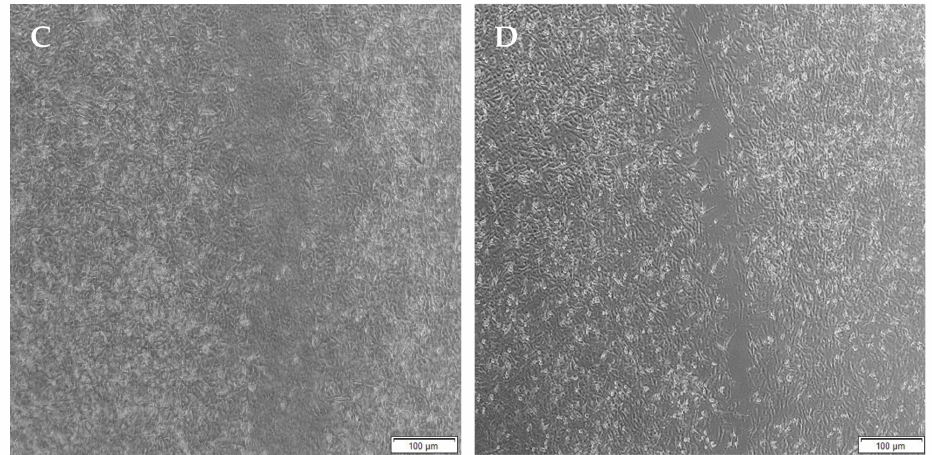
Figure 16. Micrographs of the migration of A172 cells from a wound-healing assay of the semi- IPN at ( A ) 0 h, ( B ) 8 h, ( C ) 24 h, and ( D ) 48 h. Images were captured using the 4 × objective and the phase contrast feature of an inverted light microscope. The red arrows indicate actively migrating cells at 8 h.